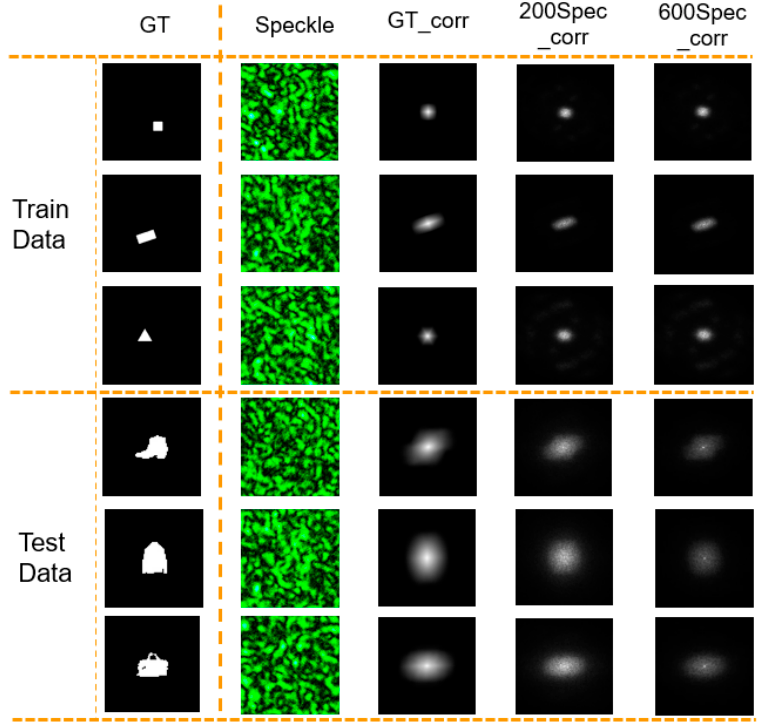
Figure 7. Experimental data representation and display of autocorrelation reprocessing results. GT is the truth value of the target, Speckle refers to the target speckle images, GT_corr represents the truth value autocorrelation, 220Spec_corr is the speckle autocorrelation under 220-mesh frosted glass, and 600Spec_corr is the speckle autocorrelation under 600-mesh frosted glass.